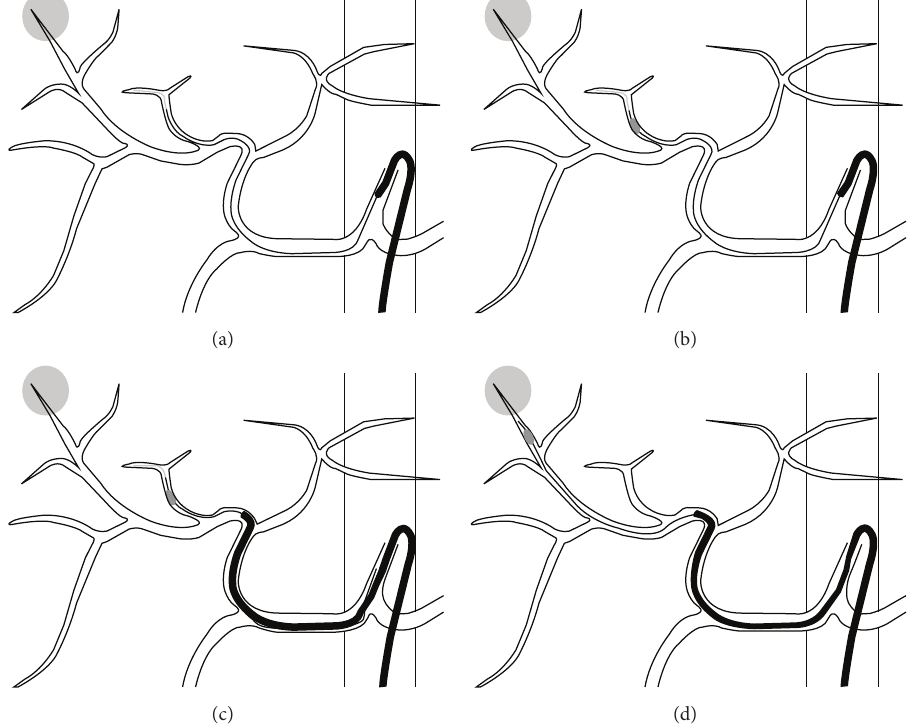
Figure 1: Schematic of the balloon anchor technique. (a) When selective cannulation of the feeding artery of the tumor was not possible using conventional methods, a microballoon catheter was inserted into a nontarget branch. (b) The balloon was inflated and fixed in the vessel. (c) The parent catheter was advanced along the fixed microballoon catheter. (d) The microballoon catheter was advanced into the feeding artery and selective balloon-occluded transarterial chemoembolization was